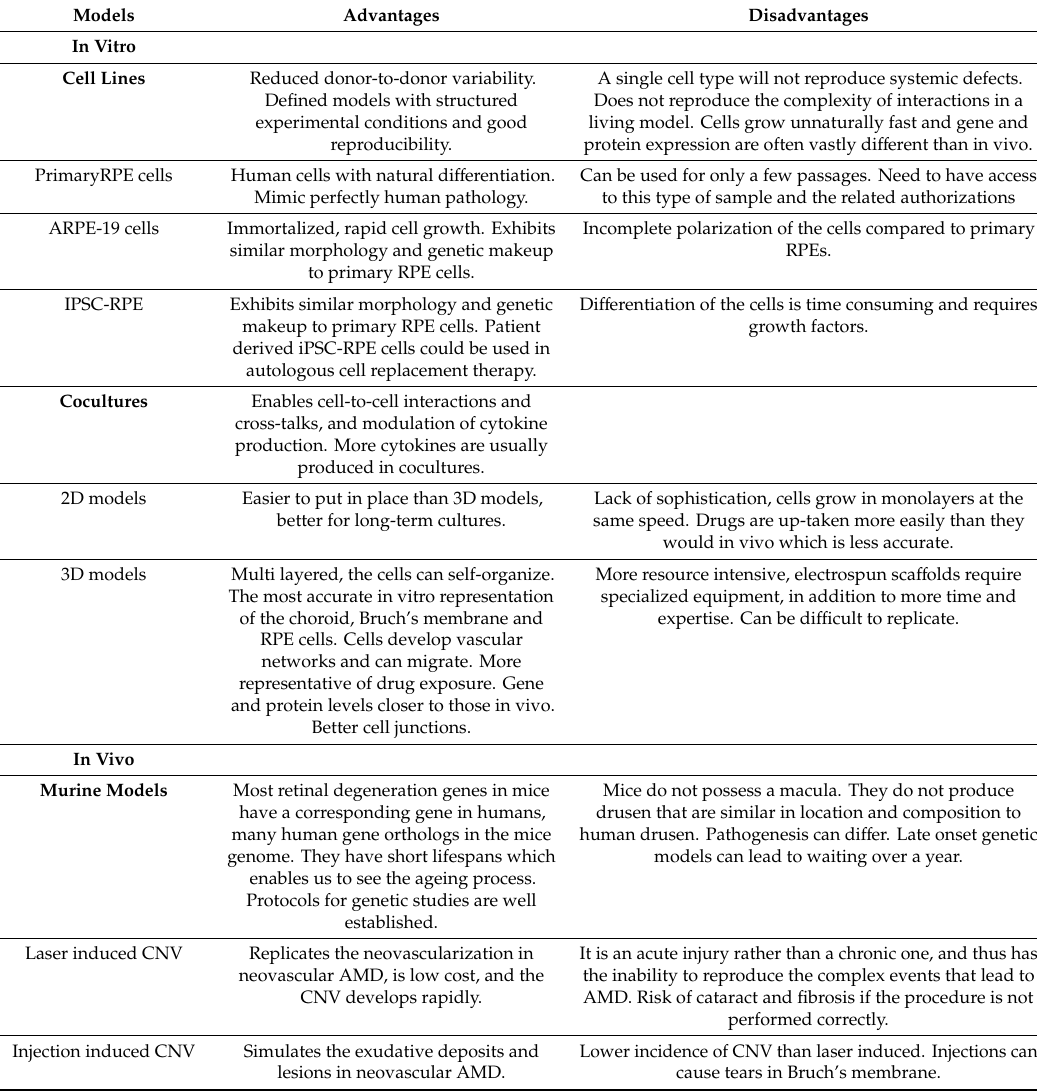
Table 1. Advantages and disadvantages of neovascular